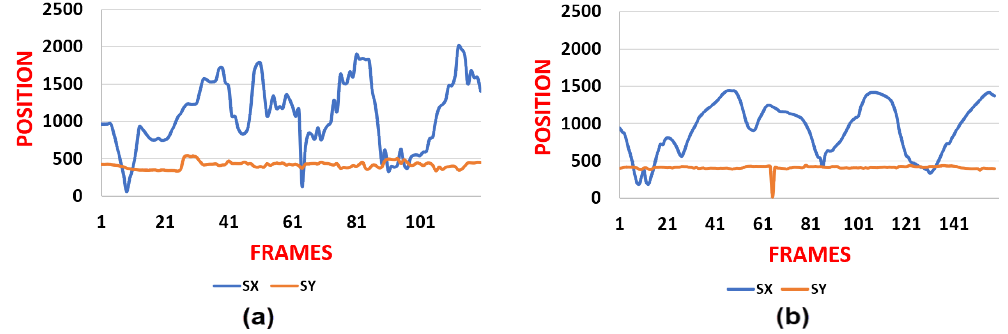
Figure 12. Change in viewpoint for variation 1 (pixels) ( a ) RC, ( b )